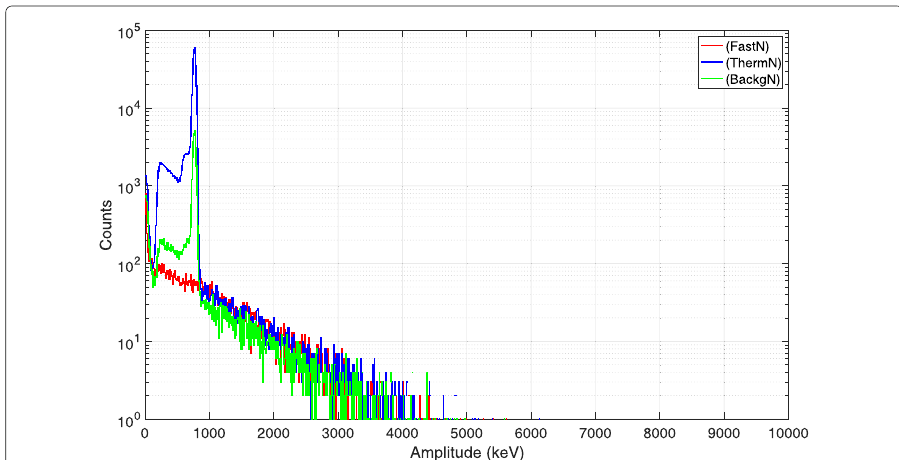
Fig. 6 Simulated total energy deposition for configurations (FastN), (ThermN) and (BackgN) in the full energy emission range of the Pu/Be source